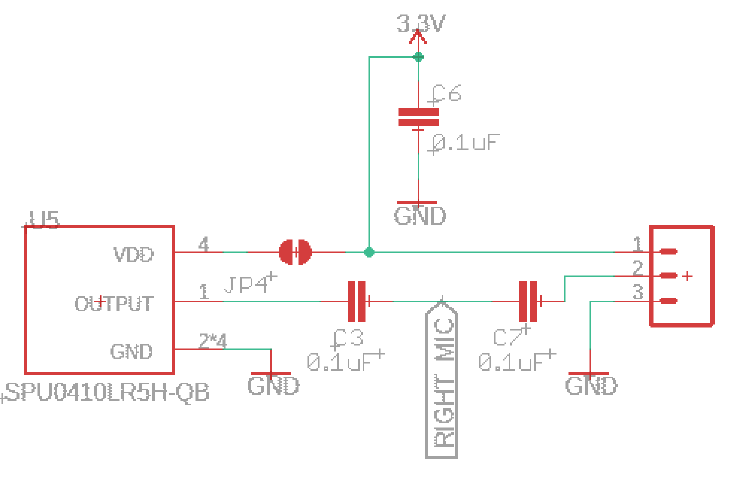
Figure 5. Built-in ultrasonic microphone